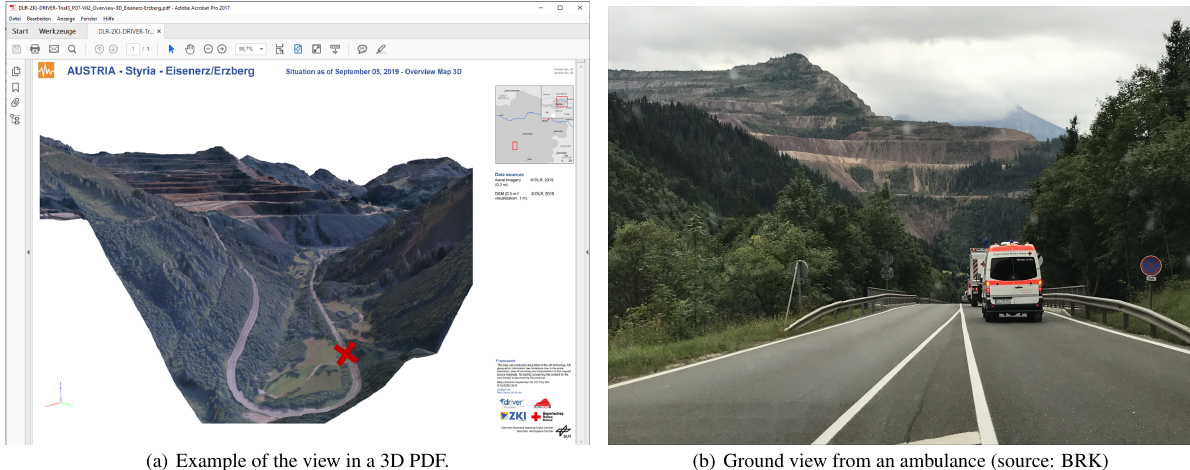
Figure 8. Remote route planning in the operation room for rescue teams to reach the deployment site with the help of a 3D PDF. (a) shows the terrain and road network in a 3D PDF. (b) shows the ground view roughly from the in (a) red marked position out of an